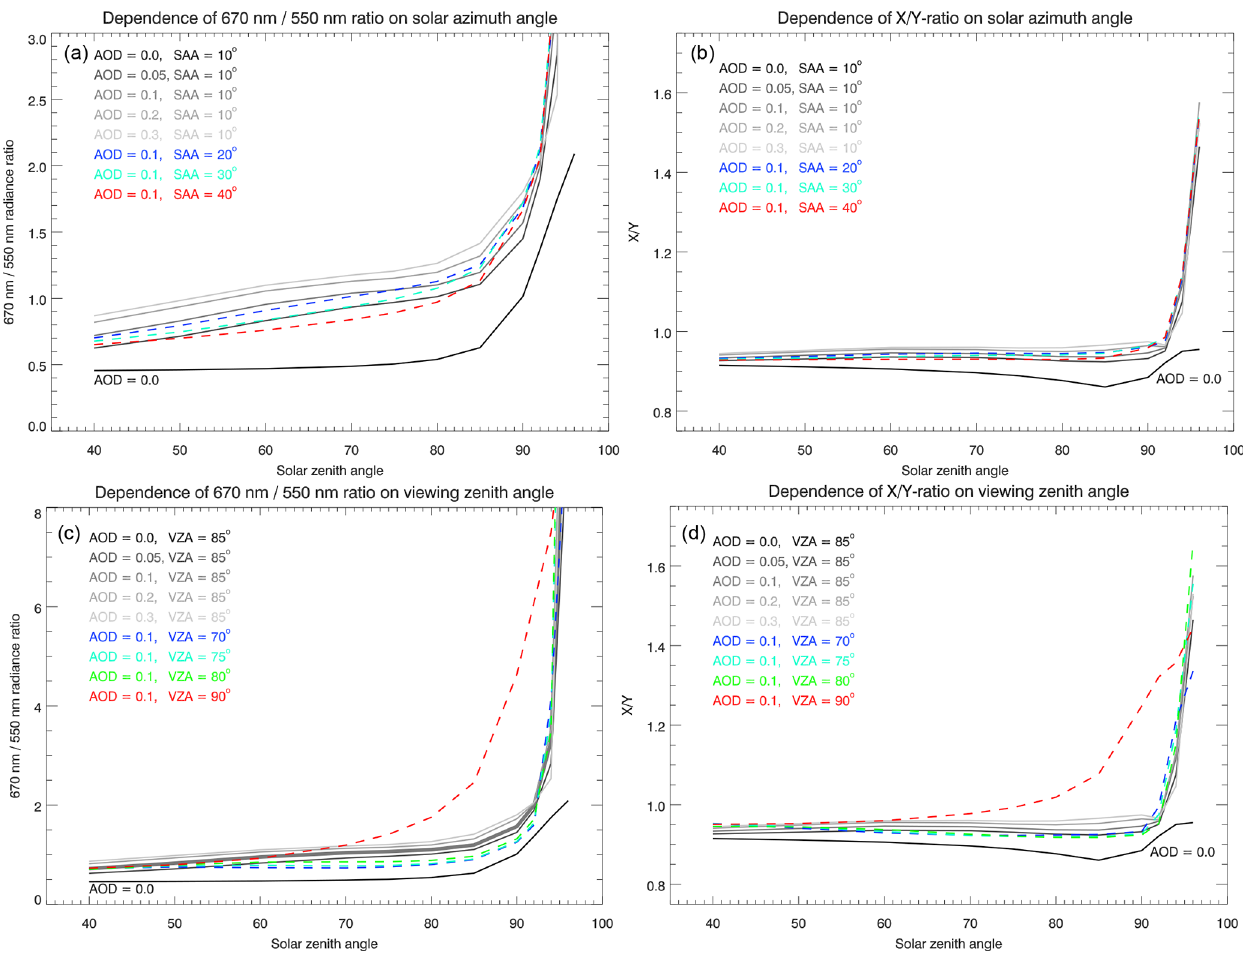
Figure 7. Ratio of the scattered solar radiances at 670 and 550nm (a, c) and the X/Y tristimulus value ratio (b, d) as a function of SZA and for different solar azimuth angles (SAAs; a, b ), different viewing zenith angles (VZAs; c, d ), and different values of the stratospheric AOD. Other relevant parameters: TOC = 300DU, A S = 0 . 3, r med = 250nm, S = 1 . 5, and VZA = 85 ◦ for (a) and (b) and SAA = 10 ◦ for (c) and (d) . Note that the ordinate ranges differ between the different panels of this